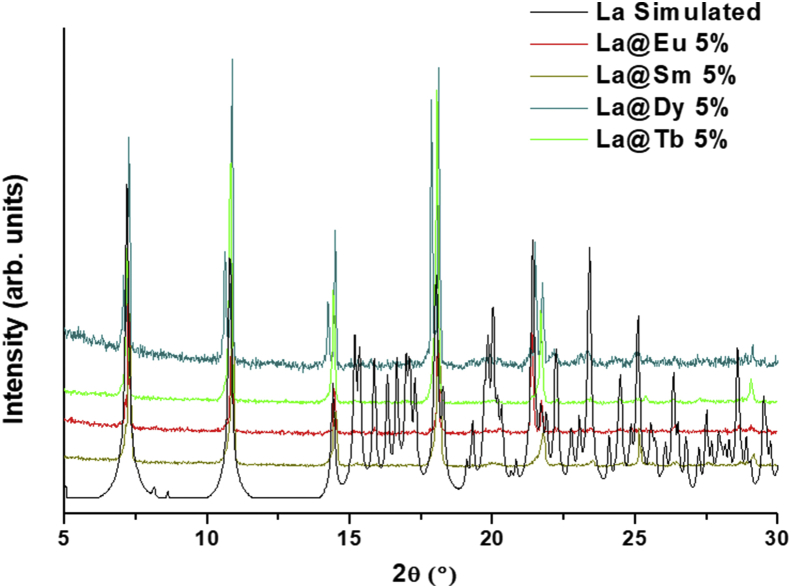
Powder X-ray diffraction of the doped compound [La0.95Ln0.05(4-OHBBA)3(H2O)2] (Ln = Sm, Eu, Tb and Dy).